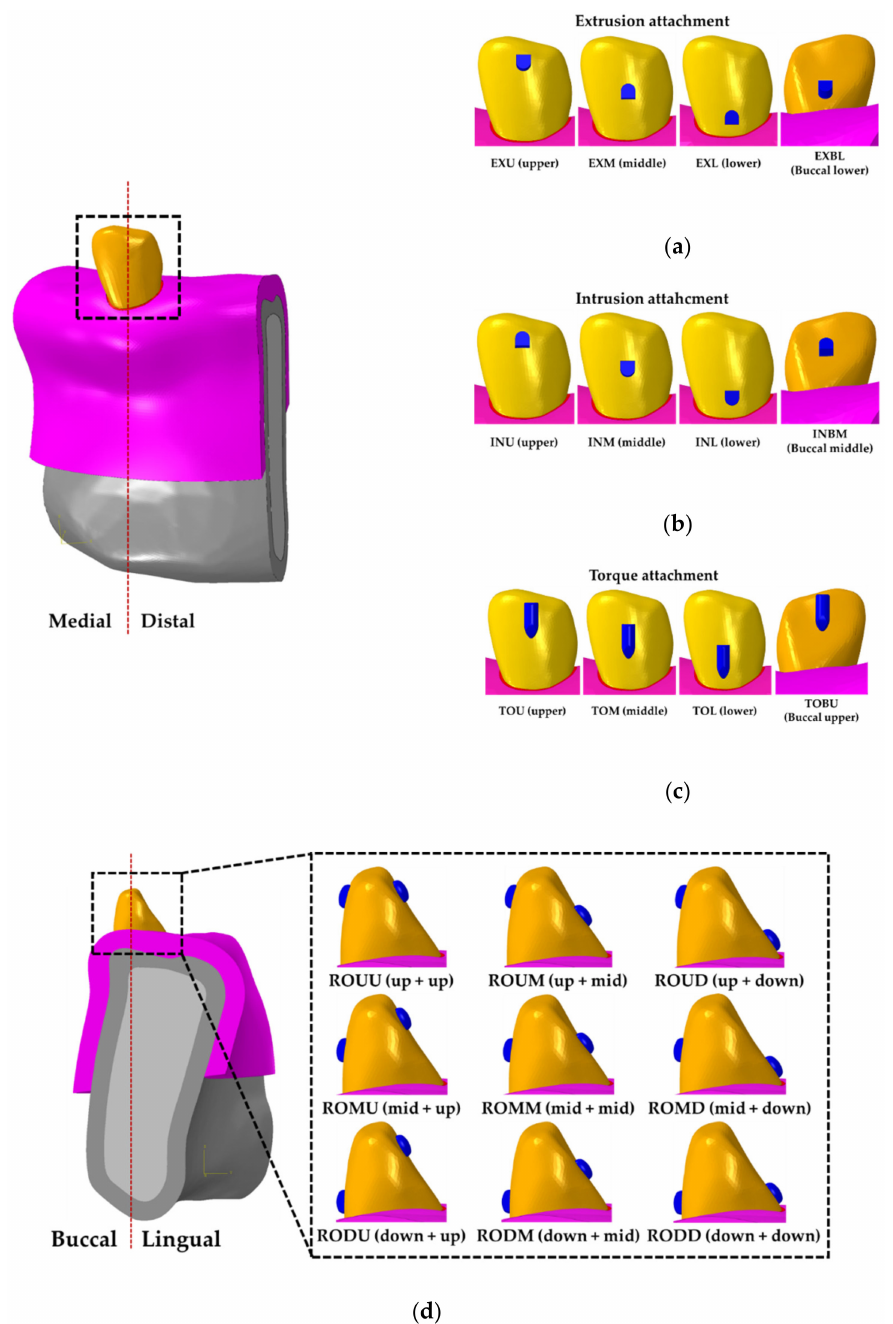
Figure 6. Construction of the treatment model considering various positions of the attachment on teeth by four teeth movements. ( a ) Extrusion attachment; ( b ) Intrusion attachment; ( c ) Torque attachment; and ( d ) Rotation